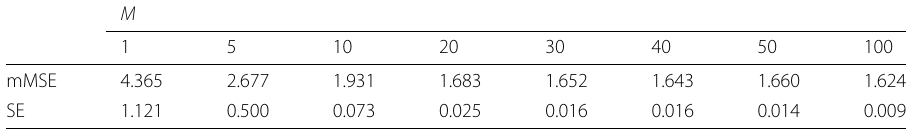
Table 1 mMSE and standard errors (SE) for LSP-HATS with an increasing number of realizations M used